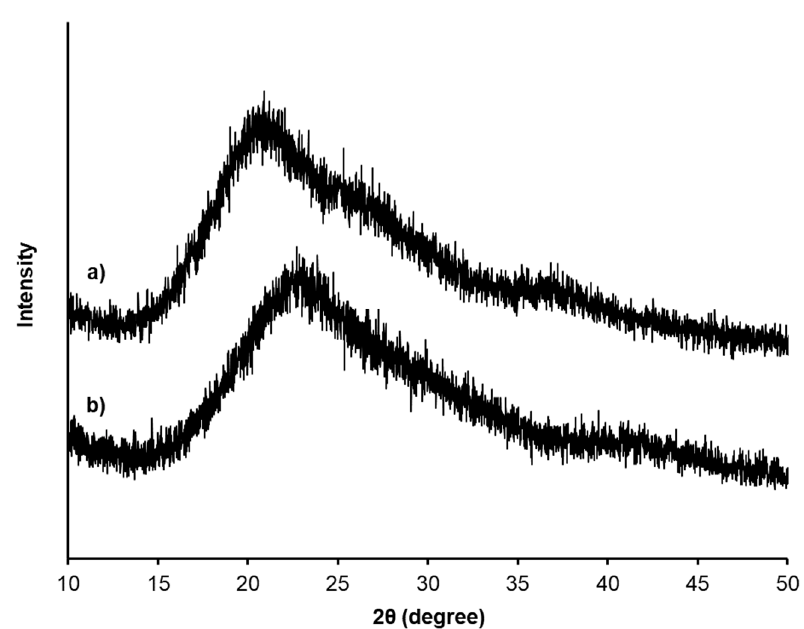
Processes 2019 , 24 , x Figure 5. XRD patterns of PNS ( a ) and HMSN ( b ). Figure 5. XRD patterns of PNS ( a ) and HMSN ( b ).